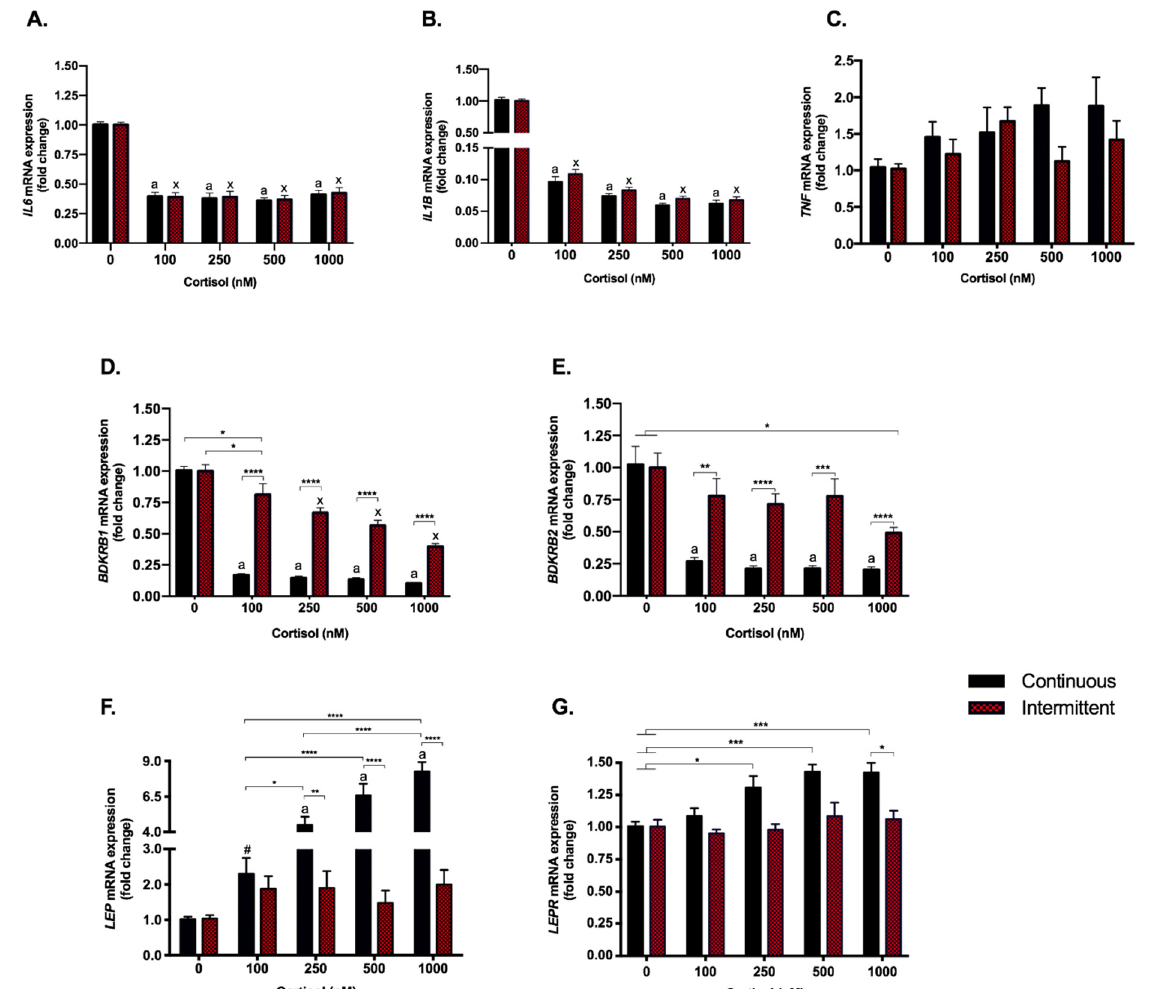
Figure 3. Inflammatory genes–gene expression. RT-qPCR of IL6 ( A ), IL1B ( B ), TNF ( C ), BDKRB1 (B1R) ( D ), BDKRB2 (B2R) ( E ), LEP ( F ) and LEPR ( G ) in SGHPL-4 cells treated with continuous or intermittent exposure to cortisol (100, 250, 500, 1000 nM) and vehicle (0 nM) in the medium. Data were compared by two-way ANOVA with Tukey multiple comparisons test. Interaction between (continuous or intermittent) exposure to cortisol and cortisol dose was found for B1R ( p < 0.0001), B2R ( p = 0.0066), and LEP ( p < 0.0001). Data are presented as mean ± SEM. * p < 0.05; ** p < 0.01; *** p < 0.001; **** p < 0.0001; #, p = 0.9356; for continuous exposure: a, p < 0.0001 vs. control; for intermittent exposure: x, p < 0.0001 vs. control. IL6 , Interleukin 6; IL1B , Interleukin 1 β ; TNF , Tumor necrosis factor α ; B1R , Kinin B1 receptor; B2R , Kinin B2 receptor; LEP , Leptin; LEPR , Leptin receptor. Cell treatment was repeated at least three